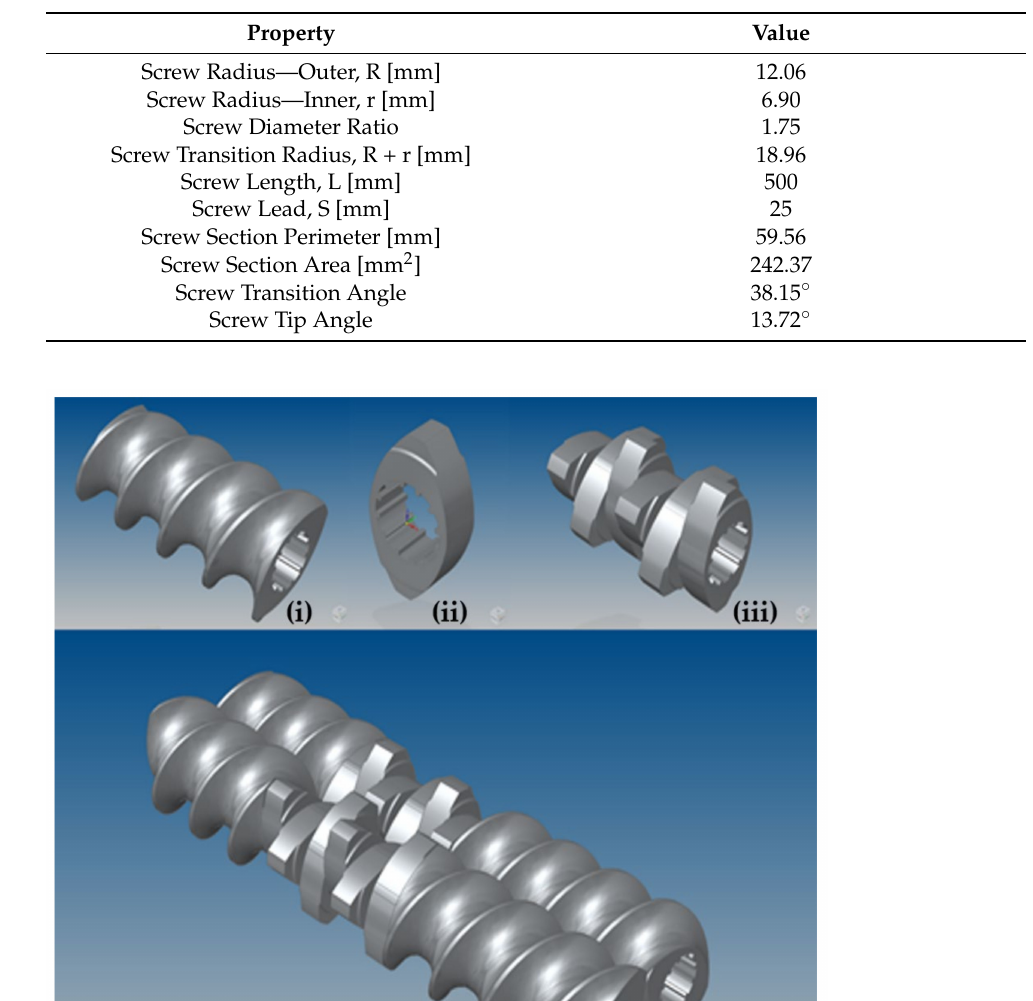
Table 2. Key ConsiGma Screw Properties.